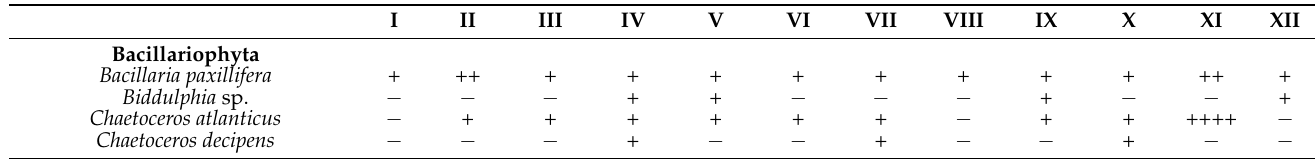
Table 6. Monthly distribution and abundance of phytoplankton species/taxa recorded in seawater ponds at Garho Fish